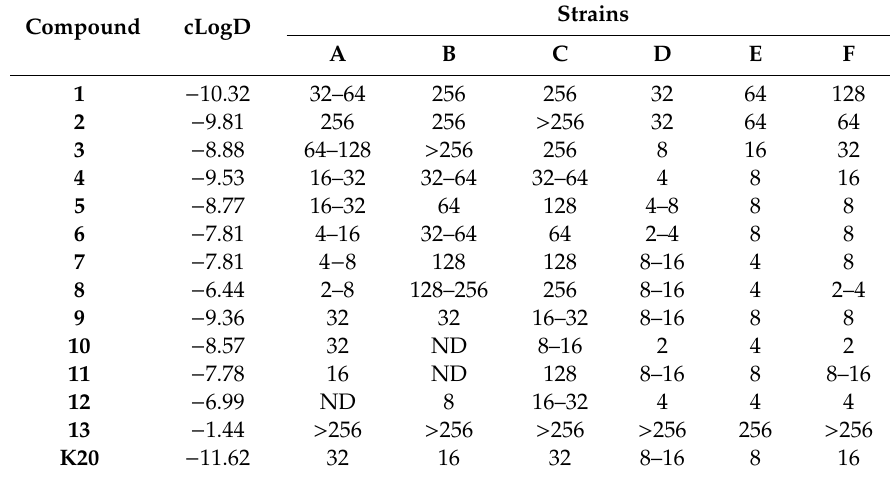
Table 1. Minimal growth inhibitory concentrations (MICs) of AKs against fungal